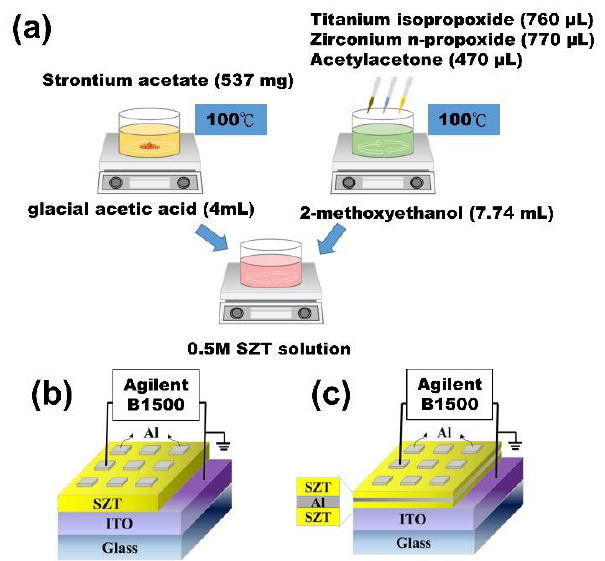
Figure 1. ( a ) Preparation of 0.5 M SZT solution. ( b ) Schematic of SZT-based RRAM devices. ( c ) Schematic of Al embedded in SZT thin-film RRAM devices.